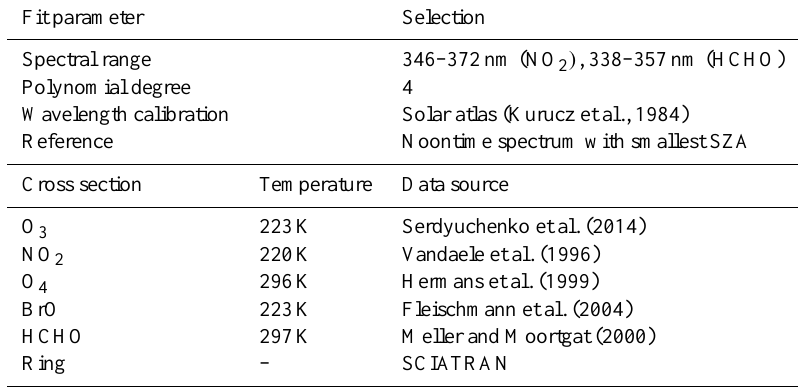
Table 2. Fit parameters and cross sections included in the spectral fitting procedure. Fit